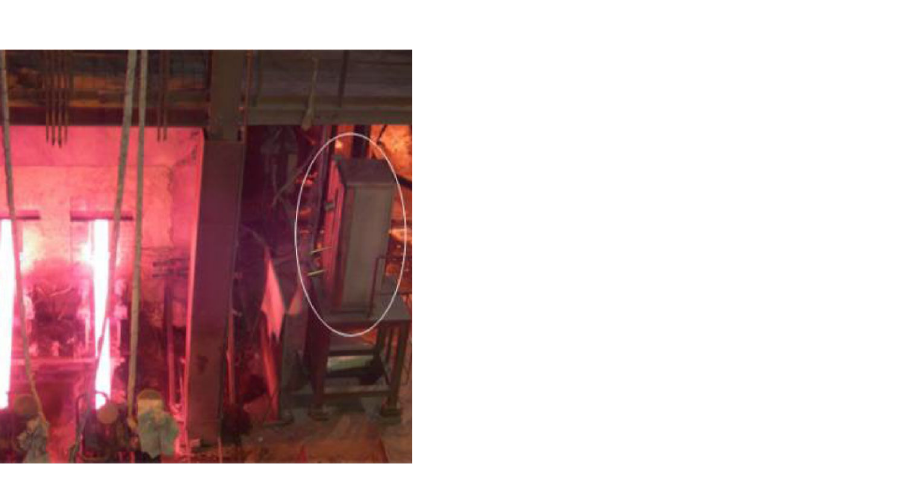
Figure 5. Temperature measurement verification of billet surface at secondary cooling